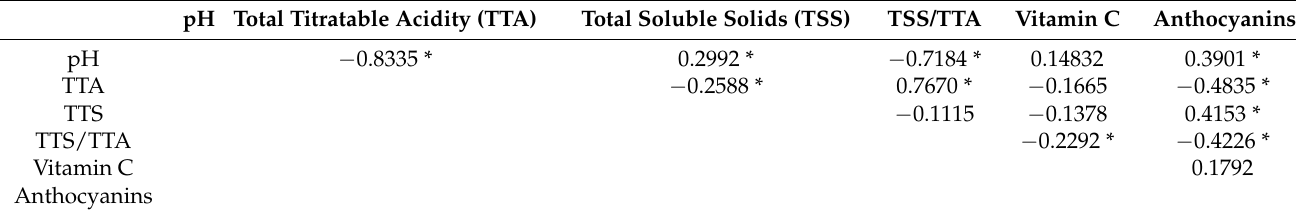
Correlation coefficient between the physical–chemical parameters of strawberries submitted to different sanitization